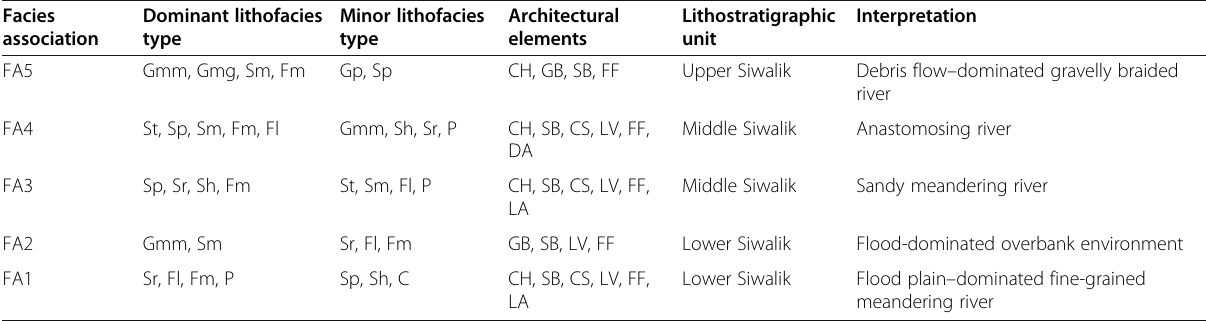
Table 2 Facies associations of the Siwalik Group in the Muksar Khola